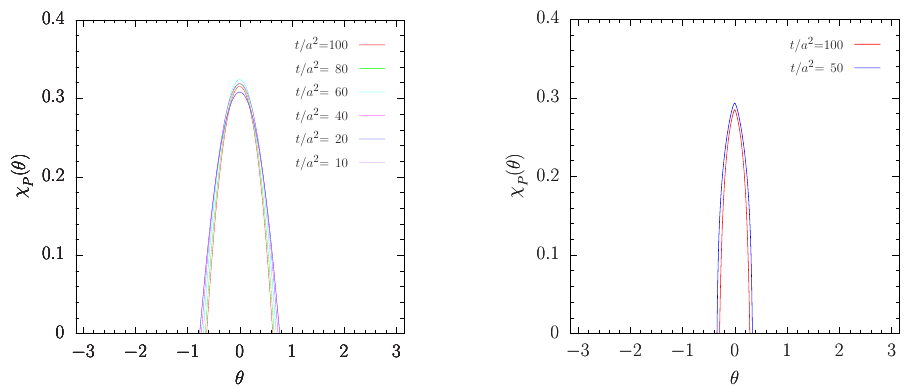
Figure 8: The Polyakov loop susceptibility as a function of θ on the 16 4 (left) and the 32 4 lattice (right) for flow times ranging from t / a 2 = 10 to